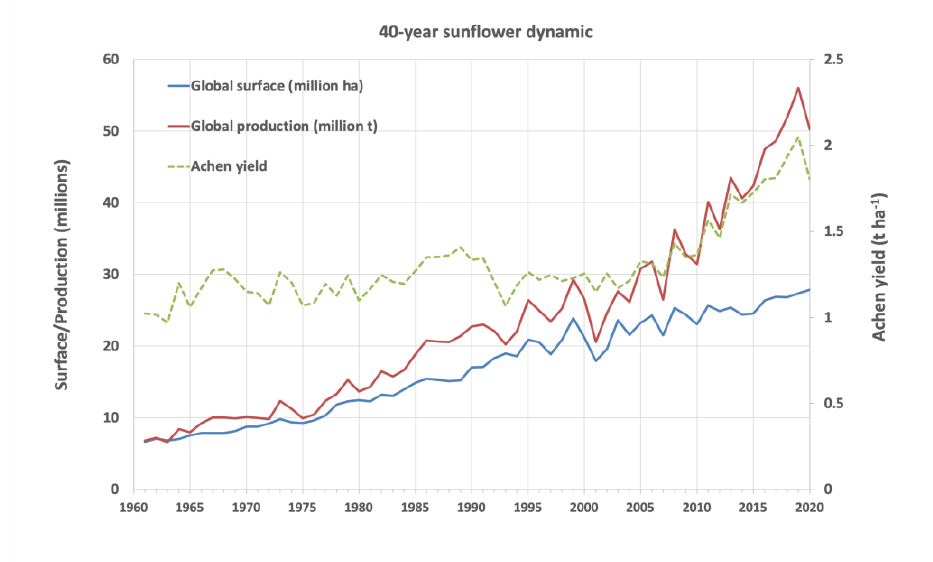
Figure 2. Dynamics of global sunflower cultivation and productivity over the last 40 years. (Data source: FAOSTAT)